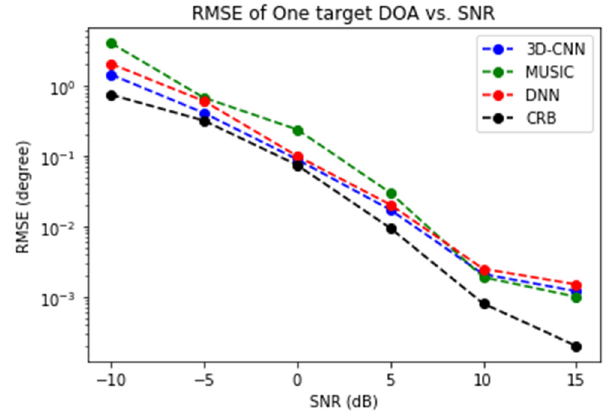
Figure 8. The RMSE of DoA estimation vs. SNR.